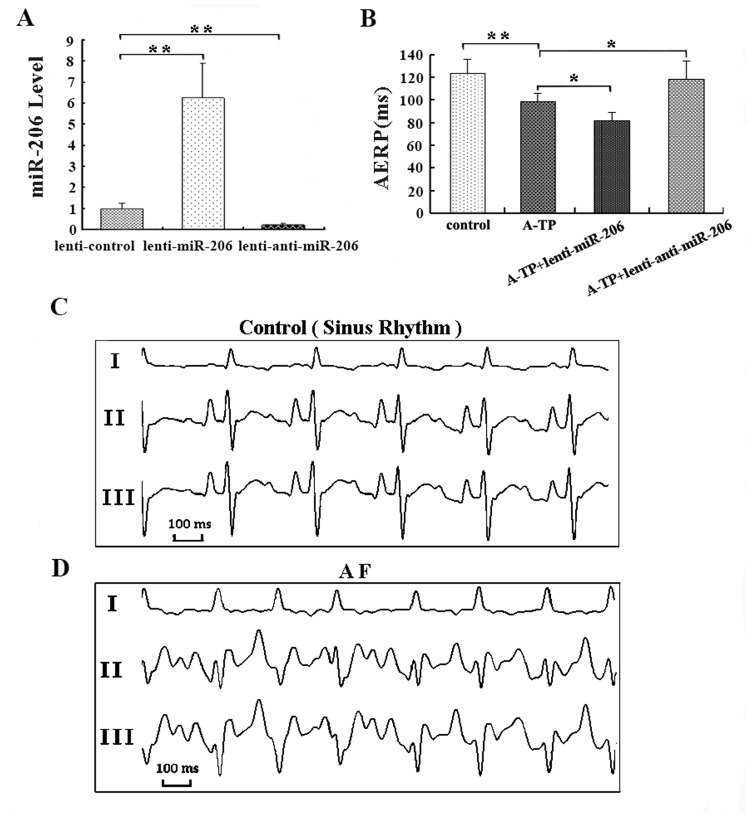
Characterization of atrial fibrillation (AF) and AERP in the canine model.AF was induced by A-TP for 4 weeks. During each week of A-TP, a surface electrocardiogram (ECG) was recorded to determine the presence of AF by turning off the pacemaker. The atrial effective refractory period (AERP) was measured with S1-S2 programmed electrical stimulation, with S2 at coupling intervals starting at 150 ms and progressively shortened by 10 ms decrements and with a 2 × diastolic threshold. The longest S1-S2 coupling interval that failed to result in a propagated atrial response was taken as the local AERP. (A) The level of miR-206 in the lenti-control, lenti-miR-206, and lenti-anti-miR-206 groups two weeks after infection. (B) The AERP in control, A-TP, A-TP plus lenti-miR-206 and A-TP plus lenti-anti-miR-206 groups obtained in posterior wall of left atrium. (C) ECG of the sinus rhythm obtained. (D) ECG of AF obtained. * P < 0.05 and ** P < 0.01.